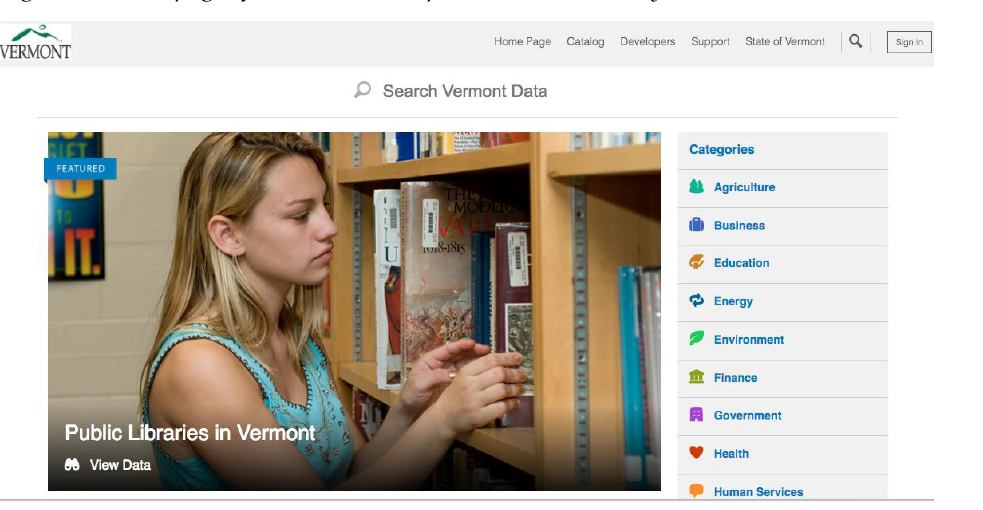
Figure 1: Front page of the Vermont Open Data Portal, July